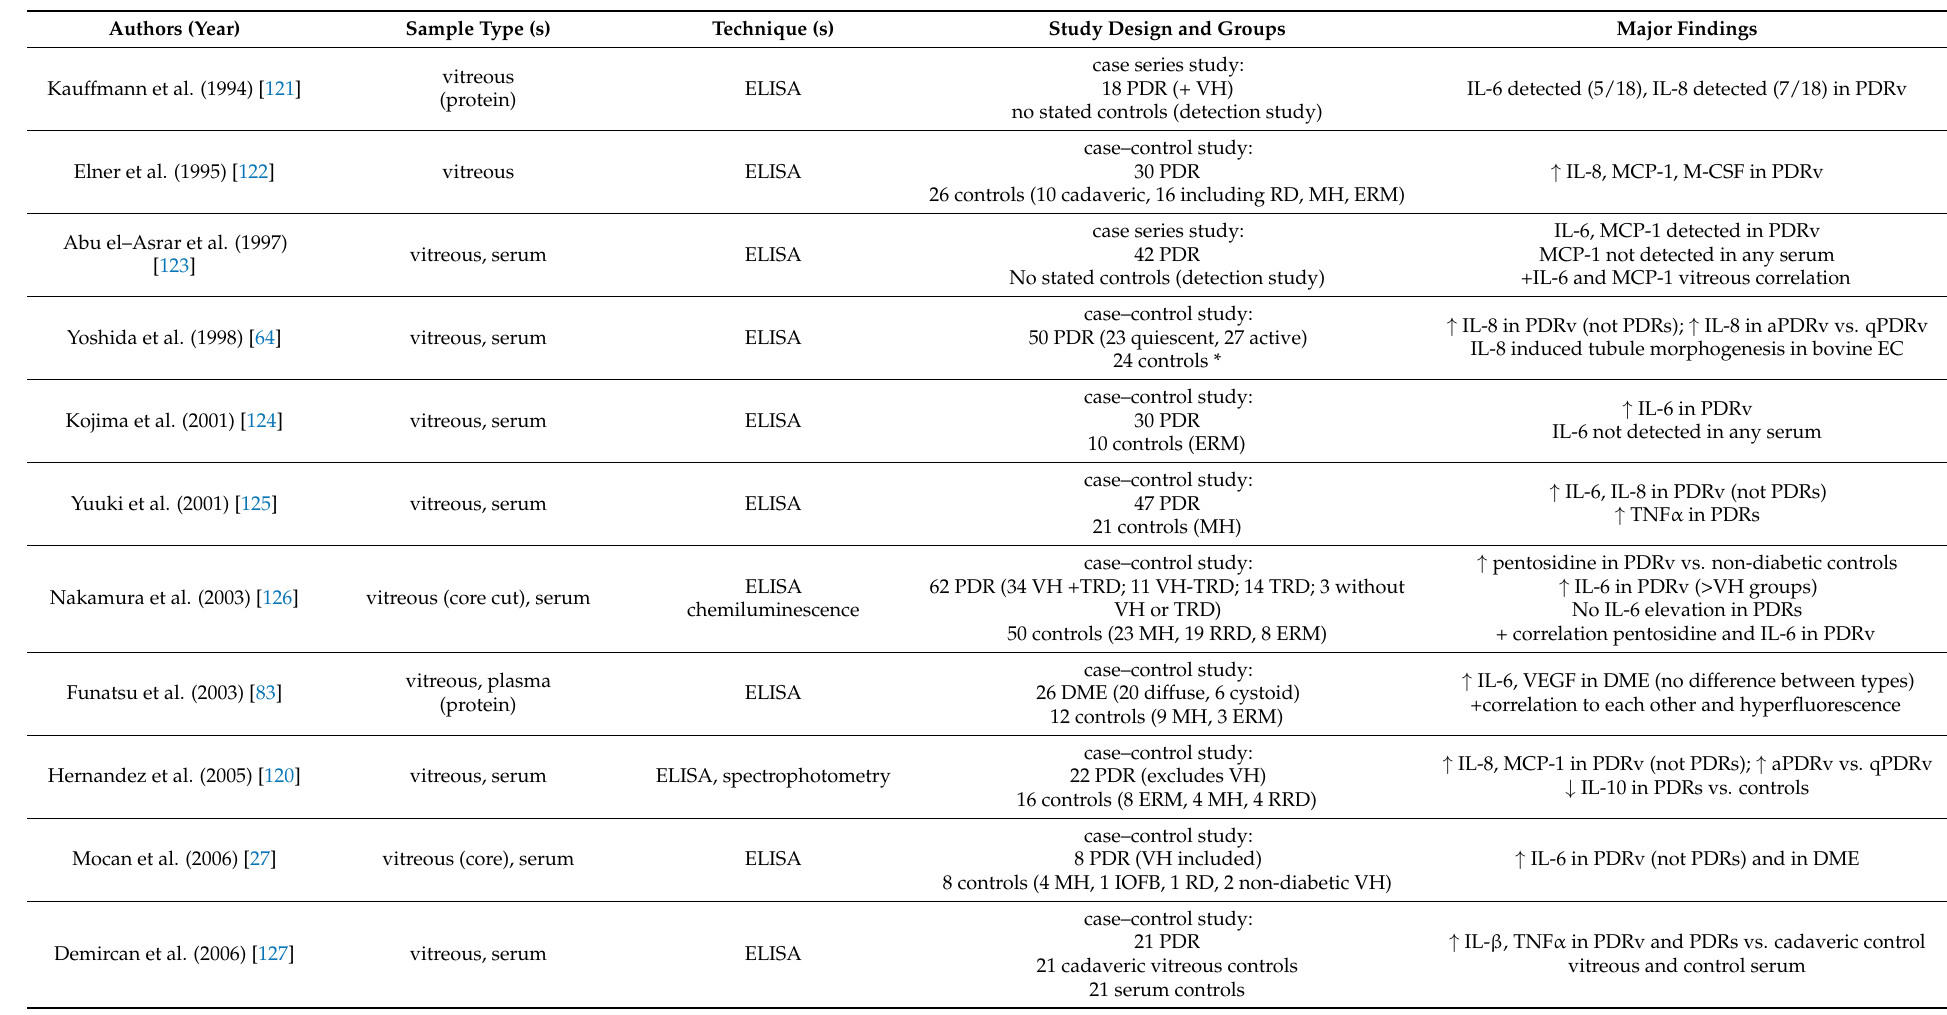
Table 1. Selected investigations of major vitreous cytokines in diabetic retinopathy. The location of vitreous sampling is listed if mentioned in the study. The specific diagnoses of the controls are listed if explicitly stated in the study, and if not, they are noted as controls